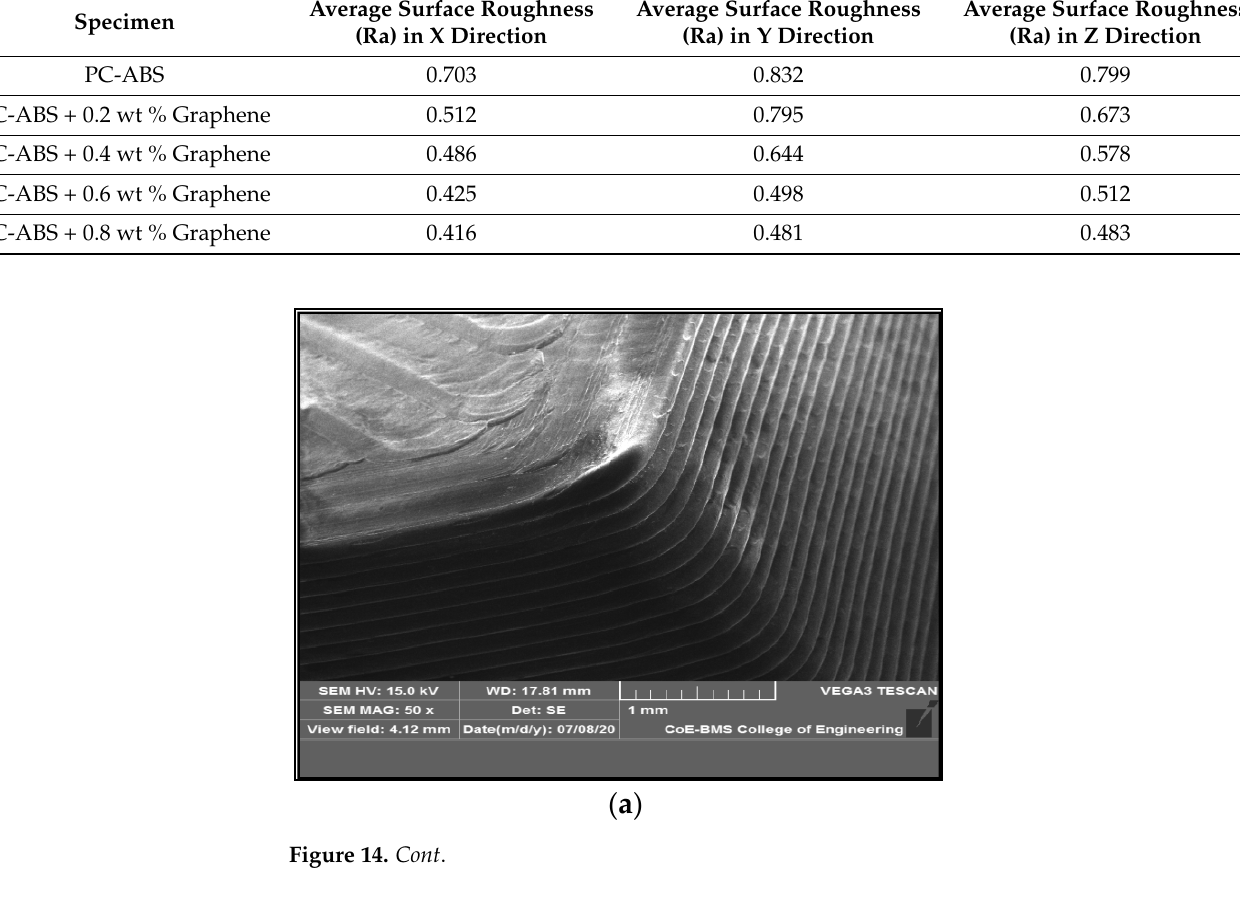
( b ) ( c ) Figure 14. Isometric view of FDM-printed parts of ( a ) PC-ABS, ( b ) PC-ABS+0.4 wt % graphene, ( c ) PC-ABS + 0.8 wt % graphene.